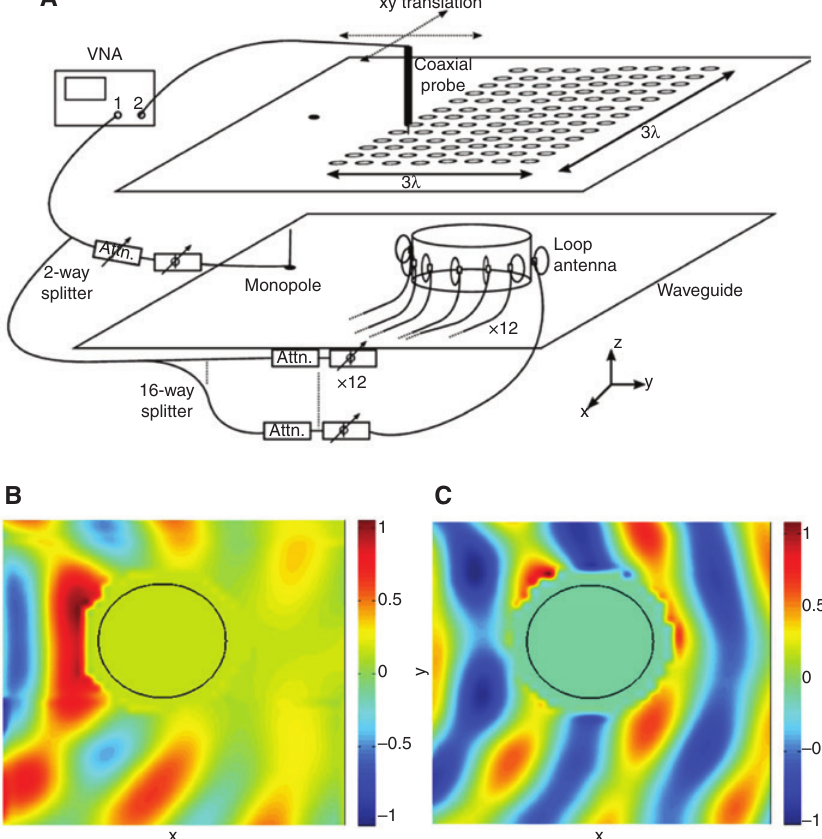
Figure 25: Experimental demonstration for active cloaking at f = 1 GHz with an HMS. (A) A schematic of the measurement setup. Obtained from [28]. (B) The measured total electric field (real part) with the cloak disabled. Obtained from [28]. (C) The measured total field (real part) with the cloak enabled. For practical reasons, the field strength inside the cloak is left unmeasured and rendered as zero-field in (B) and (C). Obtained from